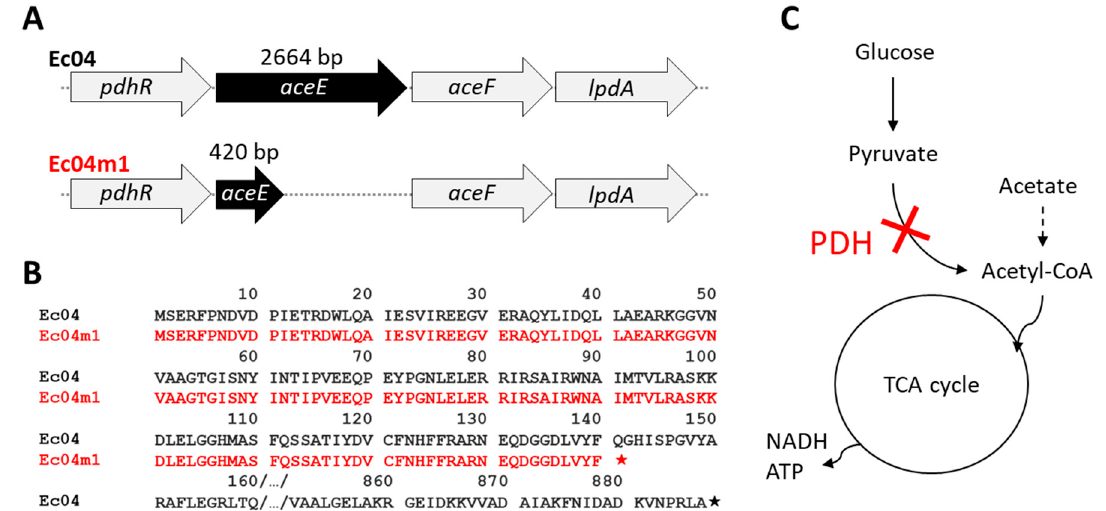
Figure 3. Detection of a nonsense mutation in the Ec04m1 variant in aceE gene encoding the pyruvate dehydrogenase E1 component of the pyruvate dehydrogenase (PDH) complex that catalyzes the conversion of pyruvate to acetyl-CoA and CO 2 . The mutation (C > T at position 421) results in a premature stop codon at the location of glutamine, leading to a truncated aceE protein (140aa). ( A ) Schematic representation of the aceE gene and its genetic environment ( pdhR-aceEF-lpdA operon) in Ec04 and Ec04m1 strains. ( B ) Protein sequence of aceE in Ec04 (887aa) and its alignment with the truncated protein in Ec04m1 (140aa); stars symbolize stop codons. ( C ) Schematic representation of the central metabolic pathway altered by the mutation in the Ec04m1 variant.